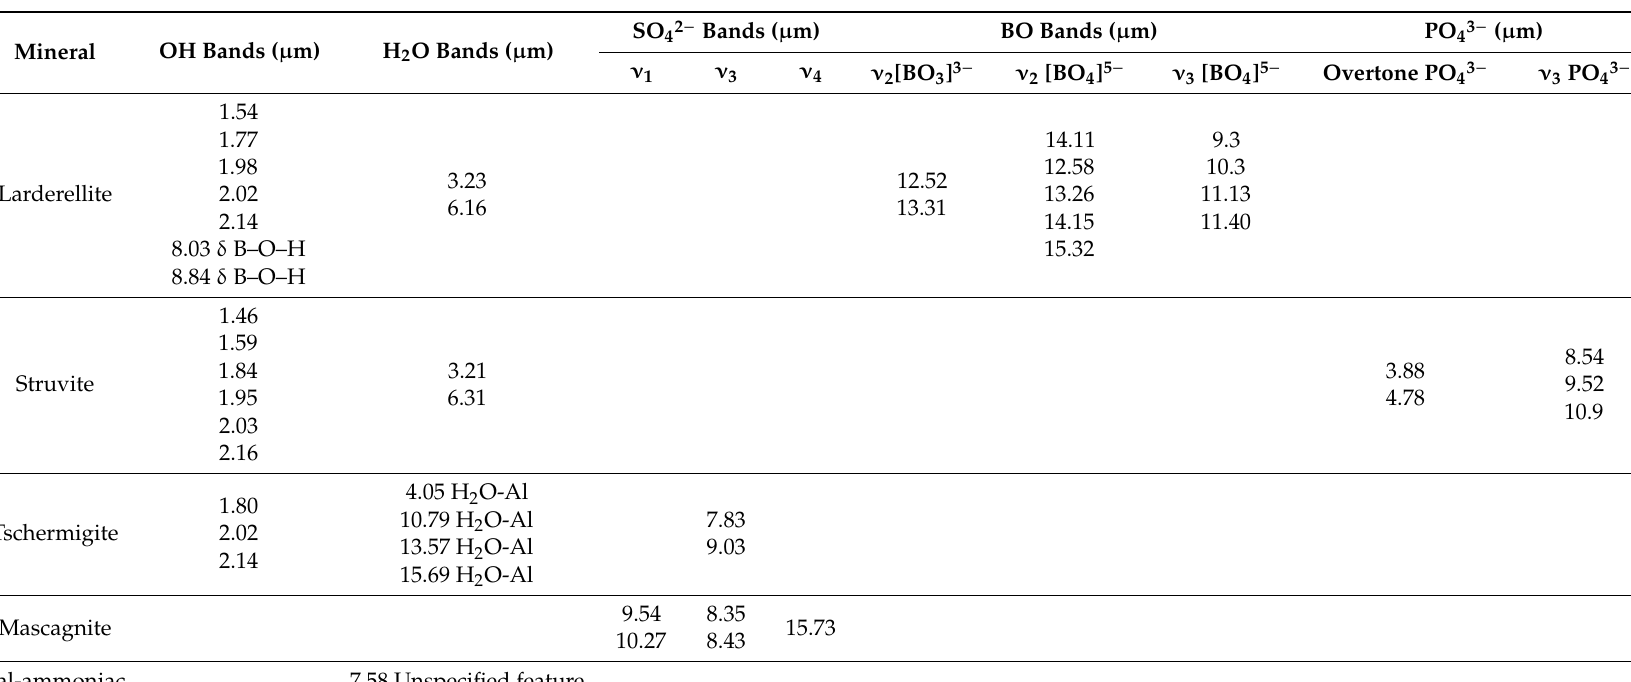
Table 3. Absorption band assignments, due to anion groups and water, in ammonium-bearing minerals’ spectra following Bishop et al. [28], Stefov et al. [40], Cloutis et al. [46], Sergeeva et al. [55] and Korybska-Sadło et al.